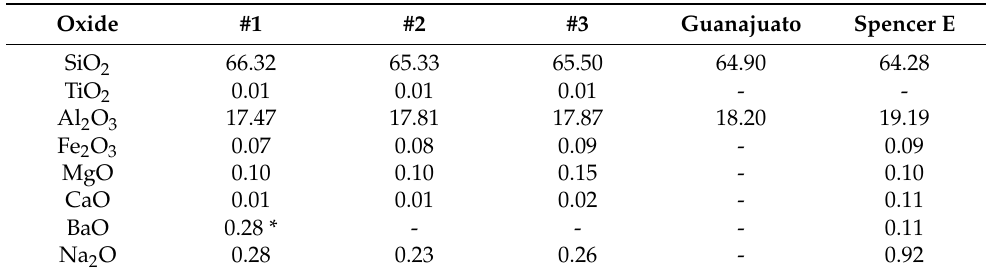
Table 3. Major element composition and structural formula of adularia samples 1, 2, and 3